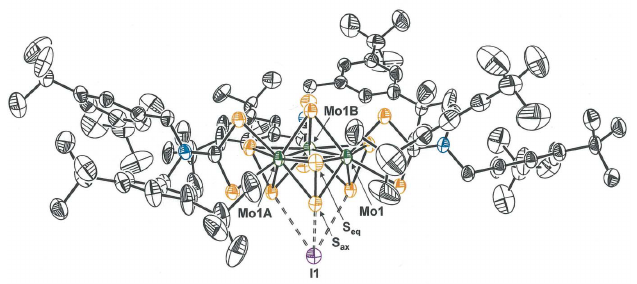
Figure 3 Side view of [Mo 3 S 7 (S 2 CN(CH 2 C 6 H 3 -3,5- t Bu 2 ) 2 ) 3 ]I (50% probability for the displacement ellipsoids) showing the proximity of the I (cid:2) anion to the S ax atoms of the (cid:2) 2 -S 22 (cid:2) ligands.